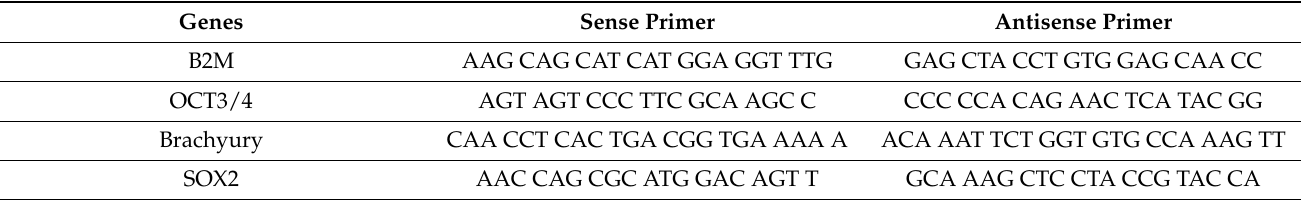
Table 2. Sequences of the sense and antisense primers used for